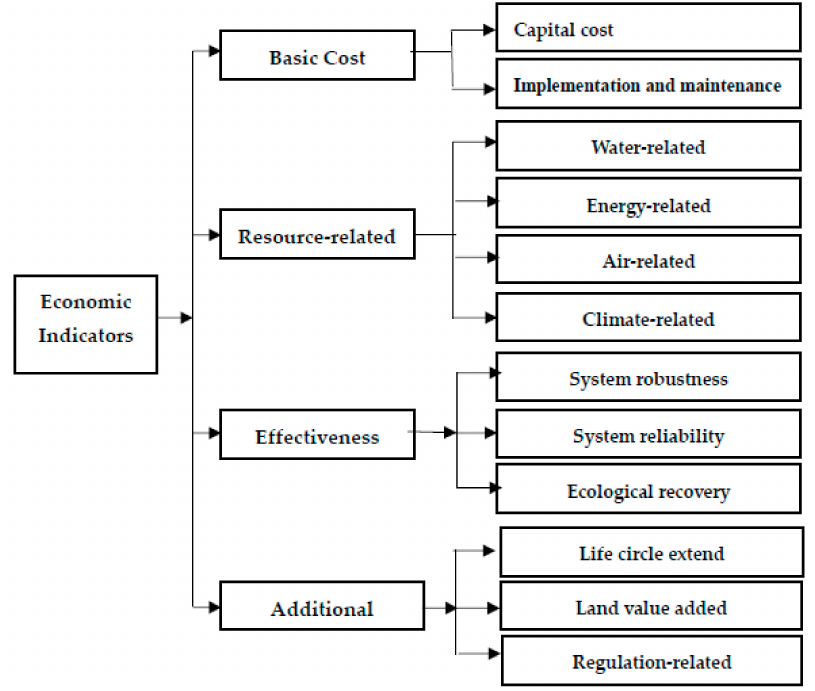
Figure 3. Economic